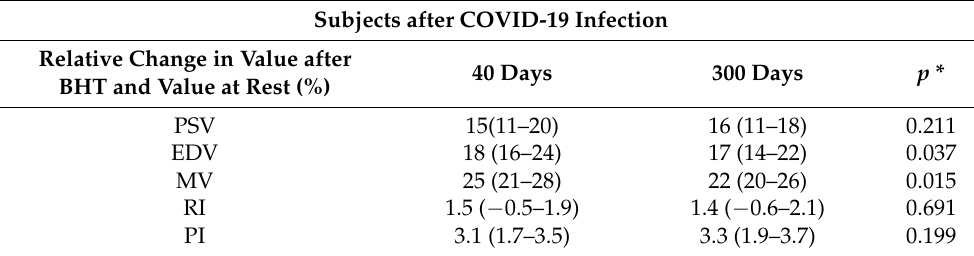
Table 10. Display of median (IQR) changes in flow rates through the MCA compared to the time elapsed since the onset of COVID-19 in